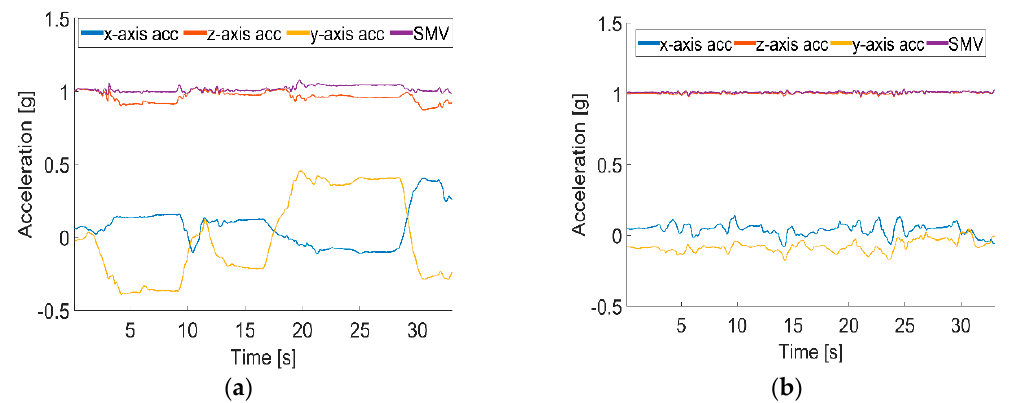
Figure 12. Accelerations in the x -, y - and z -axis and SMV readings during activities: ( a ) standing; ( b ) sitting.